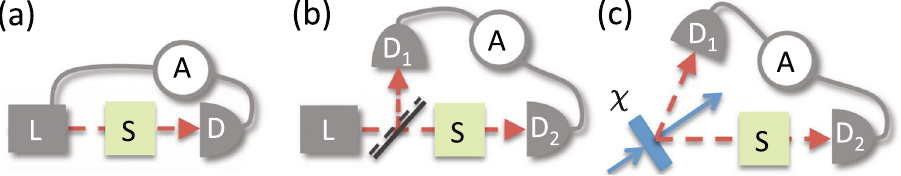
Figure 1. Absorption measurement strategies. ( a ) Direct absorption measurement with a single beam. ( b ) Differential measurement to suppress experimental classical noise. ( c ) Use of correlated twin beams generated from a nonlinear process ( χ ). In each cartoon, D denotes detectors, S denotes a sample being measured and